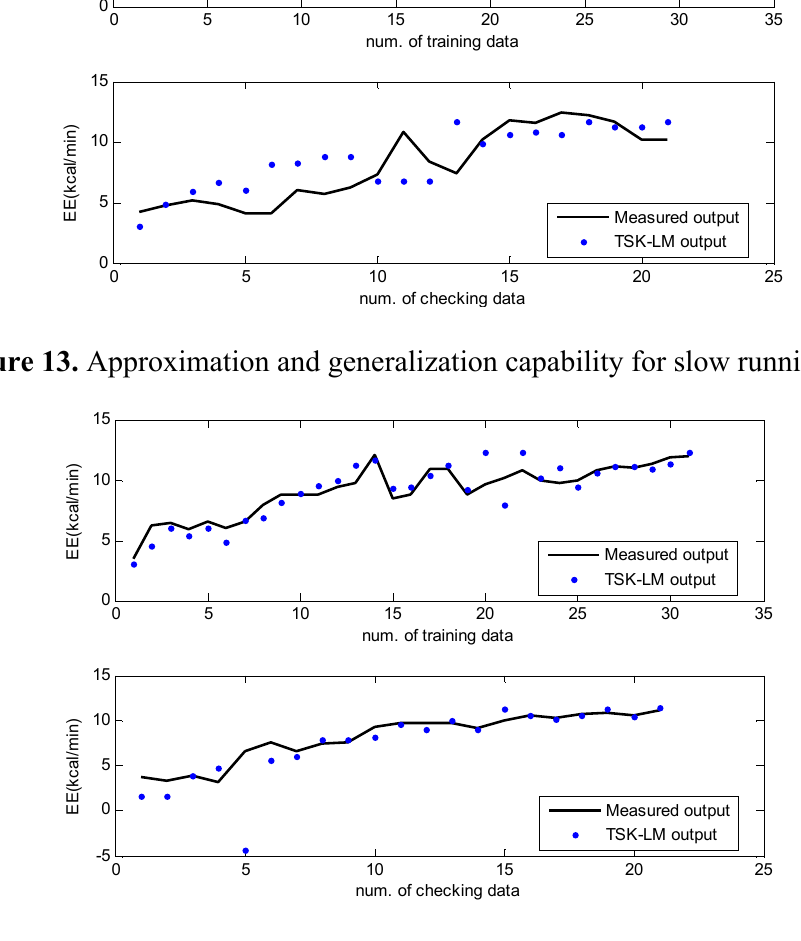
Figure 14. Approximation and generalization capability for jogging